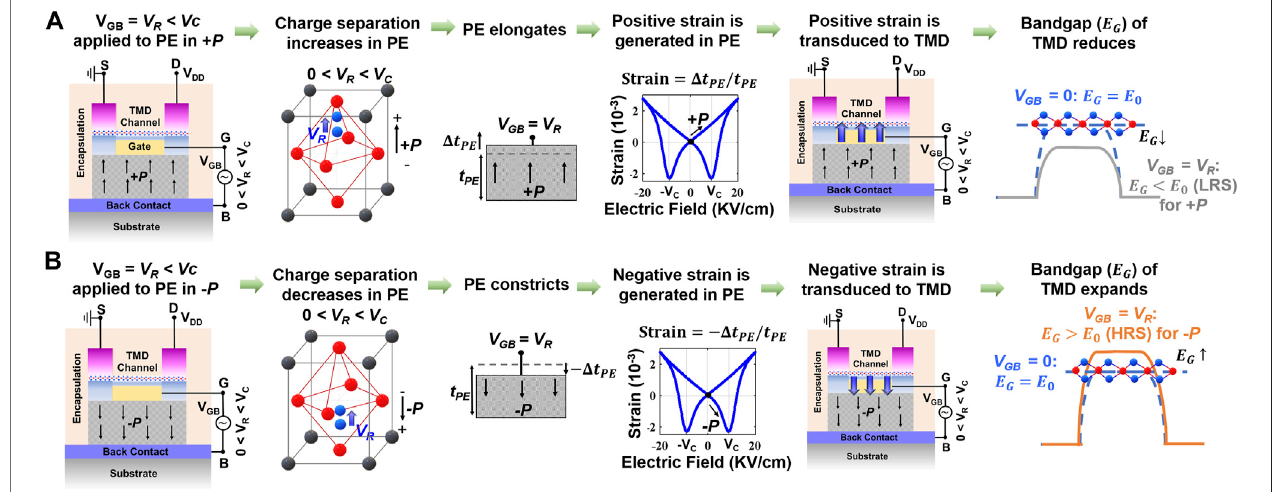
FIGURE 2 | Mechanism of polarization-dependent strain transduction in PE that enables read operation in PeFET. (A) PeFET with + P showing bandgap reduction and (B) PeFET with − P showing bandgap expansion from intrinsic position on application of read voltage that is 0 < V R < V C . The baseline for bandgap comparison is PeFET with V GB =